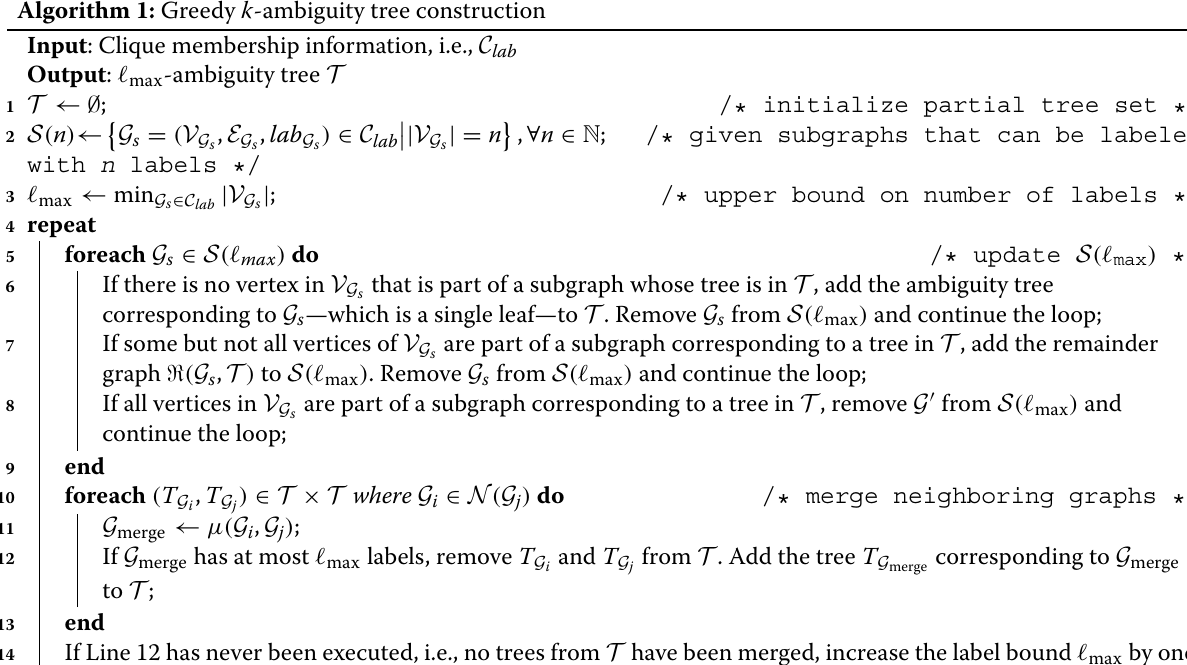
Algorithm 1: Greedy k -ambiguity tree